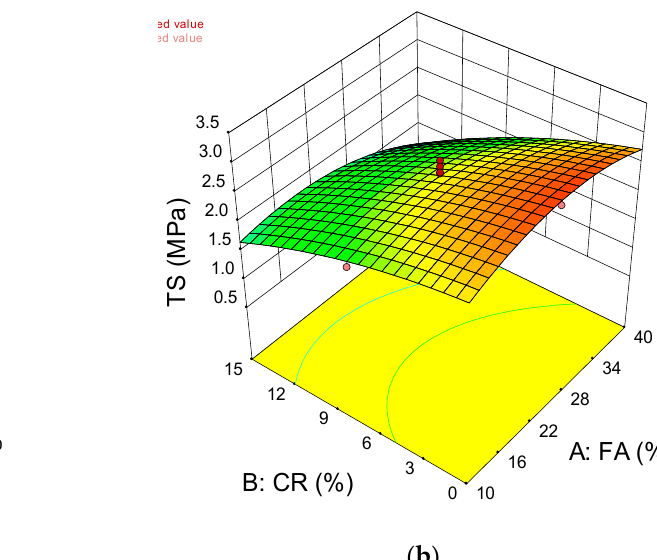
Figure 17. ( a ) 2D contour plot and ( b ) 3D response surface diagram for TS.